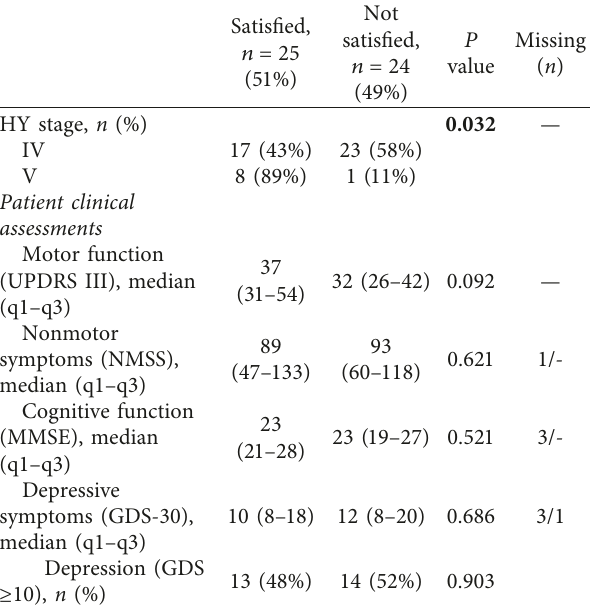
Table 6: Informal caregivers’ satisfaction with support, when the patient lives at home ( n �